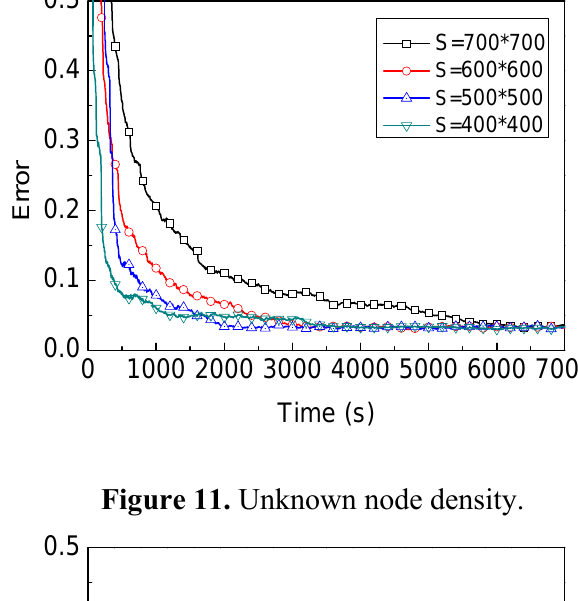
Figure 11. Unknown node density.